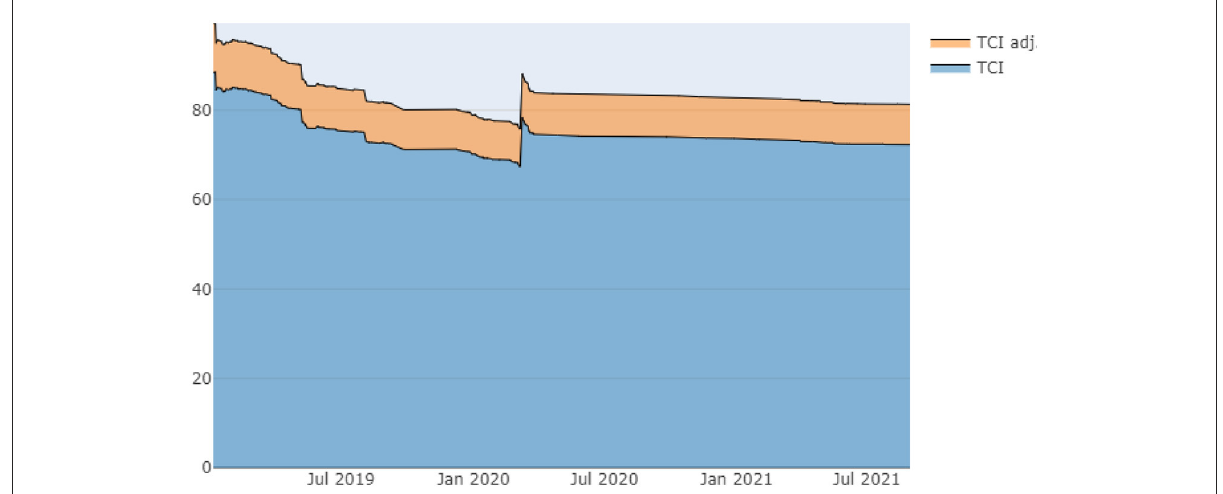
FIGURE3 Dynamic total connectedness. The of TVP-VAR approach with lag-length of order one by (BIC) criterion and a 20-step-ahead generalized forecast error variance decomposition (FEVD) are provided in this figure. The blue area represents the total connectedness (TCI) and brown area shows the adjusted TCI.